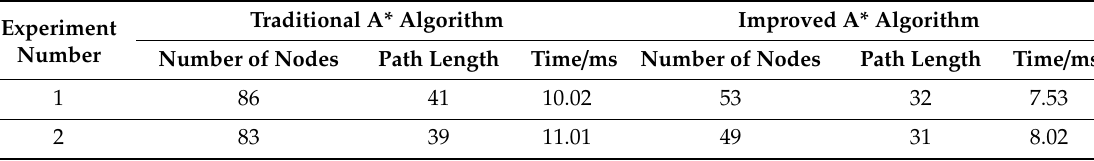
Table 4. Performance comparison between traditional A* algorithm and improved A*